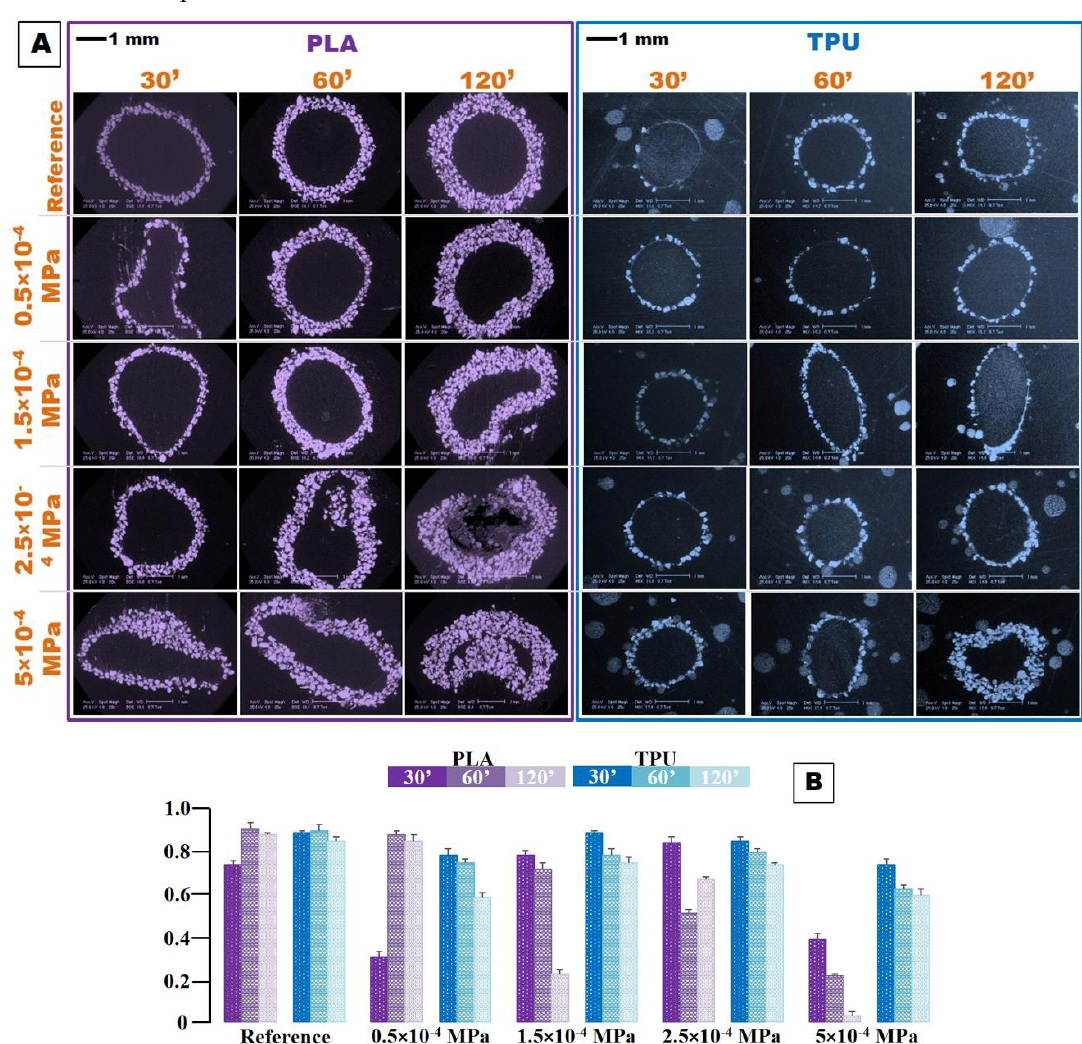
◦ C temperature. ( A ) Section morphology; ( B ) variation Figure 7. Form factor variation at 215 °C temperature. ( A ) Section morphology; ( B ) variation graphs. 300 Figure 7. Form factor variation at 215